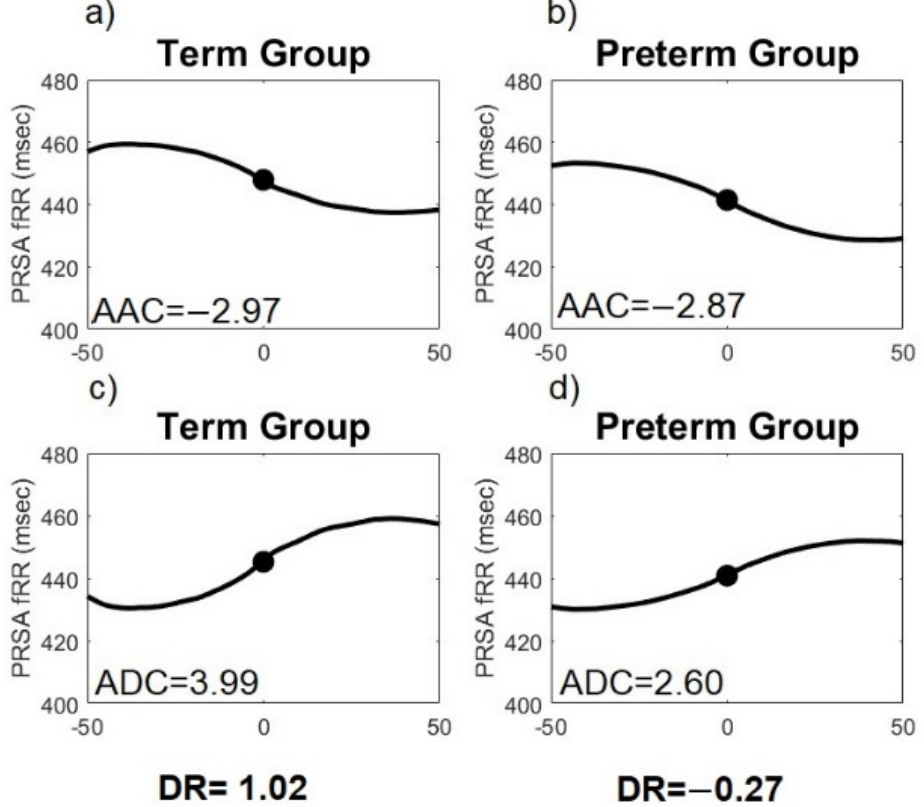
Figure 2. Examples of Phase-Rectified Signal Averaging ( PRSA ) curves ( T = 50, s = 10) of fetal heart rate for the average acceleration capacity ( AAC ) and average deceleration capacity ( ADC ) in Preterm and Term active labor. ( a ) PRSA-AAC curve for Term; ( b ) PRSA-AAC curve for Preterm; ( c ) PRSA-ADC curve for Term and ( d ) PRSA-ADC curve for Preterm. A reduction of the central part of the ADC and AAC curve in Preterm can be observed.